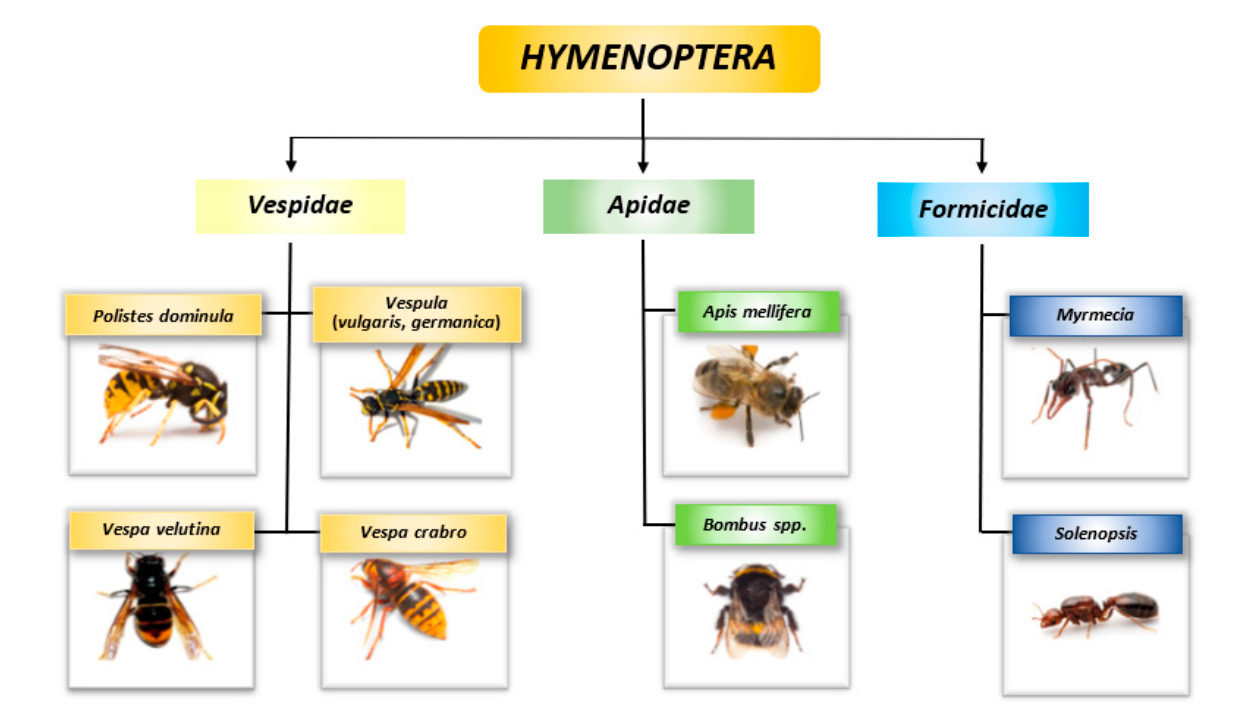
Figure 2. Taxonomy of Hymenoptera .